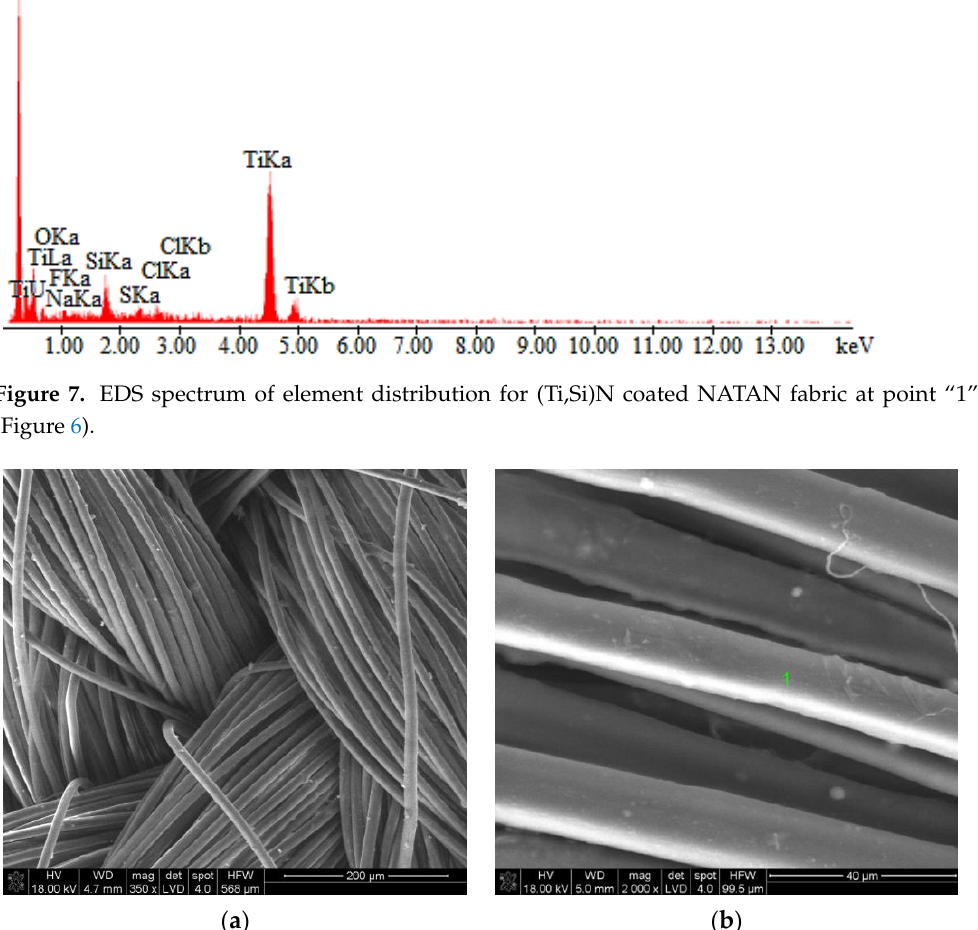
Figure 9. EDS spectrum of element distribution for Ti-Si coated NATAN fabric at point “1” (Figure 8b). The presented EDS spectrum shows the chemical composition of the surface (includ- ing the base material). The line intensity is proportional to the chemical composition of the analyzed area. Lines are visible for the layer material, titanium, and silicon. Both ele- ments are not present in the fabric. The remaining ones visible in the spectrum come from the fabrics. The height of the Ti and Si lines is proportional to the thickness of the tested layer. The exemplary test results for the PROTON fabric are also presented. Figure 10 shows the microscopic image obtained for the material coated with Ti-Si. Comparing the surface image in Figures 8b and 10b the differences probably caused by different types of substrates can be noticed. The layer on the PROTON fabric does not adhere well to the substrate, which is better shown in Figure 10c.